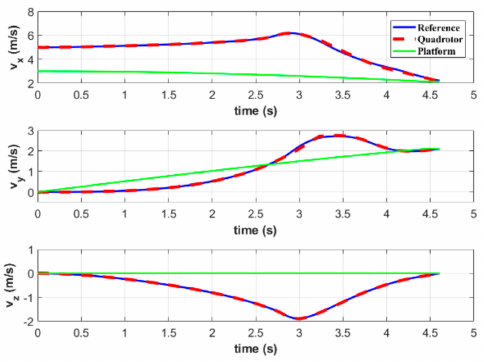
Figure 14. Velocities of the quadrotor and platform in simulation B.